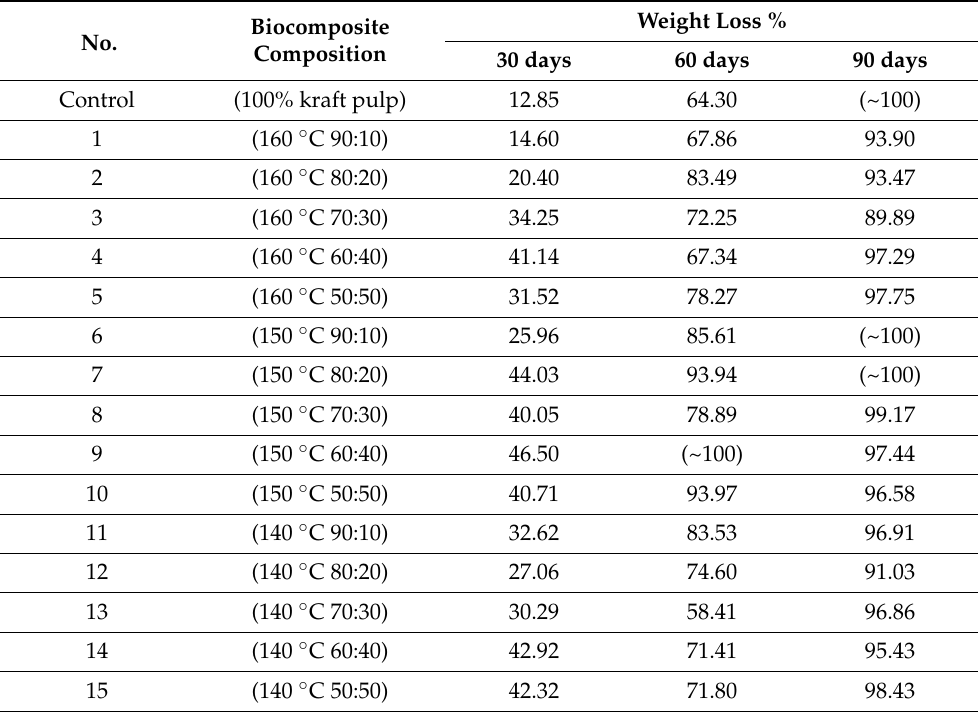
Table 1. Weight loss percentage of the biocomposites obtained after 30, 60, and 90 days of degradation in